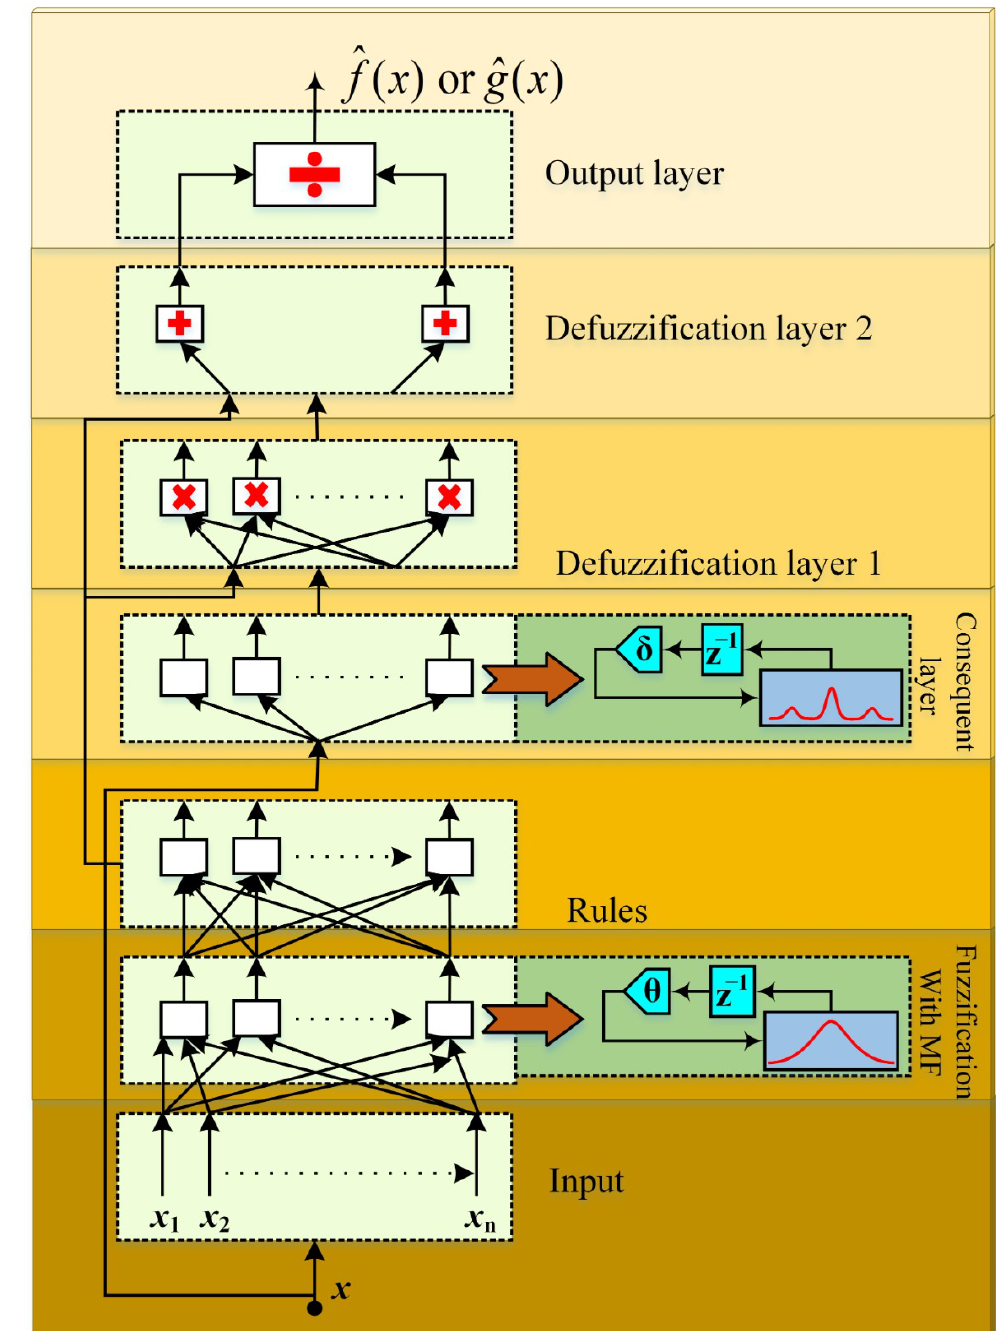
Figure 6. Architecture of Full Recurrent Adaptive NeuroFuzzy